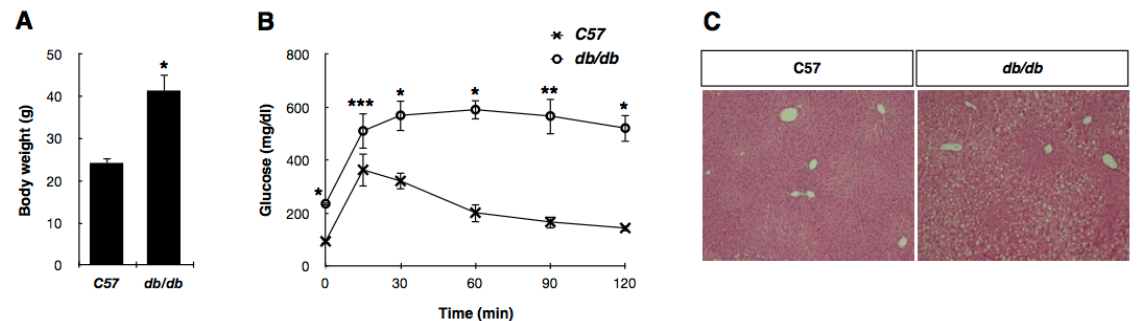
Figure 1. Physiological measurements in db/db mice. ( A ) Body weight of C57 control and db/db mice at 10 weeks; ( B ) Intraperitoneal glucose tolerance test (IPGTT) was performed by injecting 1 g/kg glucose intraperitoneally into indicated mice. Data are shown as means ± SD. p -Values were determined by Student’s t -test. * p < 0.001, ** p < 0.005, and *** p < 0.05 versus C57 control mice; ( C ) Liver sections were prepared from C57BL/6J and db/db mice, and sections were stained with